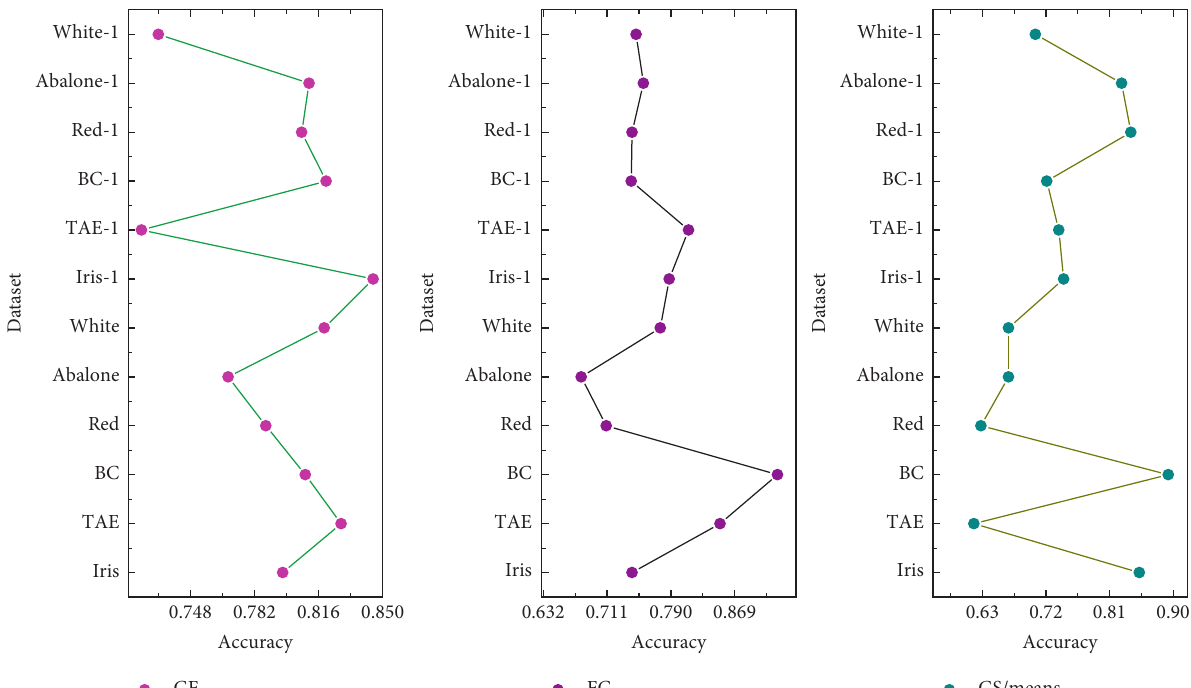
Figure 5: Effect of cloud digital feature determination method on